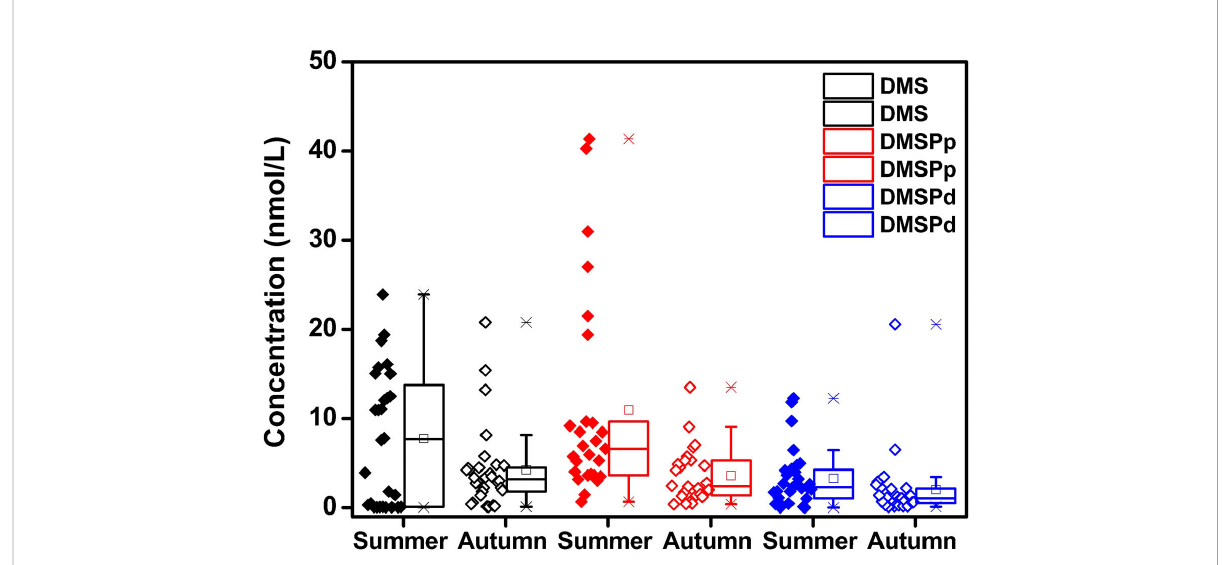
FIGURE 6 Seasonal characteristics of the concentrations of DMS, DMSPp, and DMSPd in the surface waters of BS and NYS in summer and